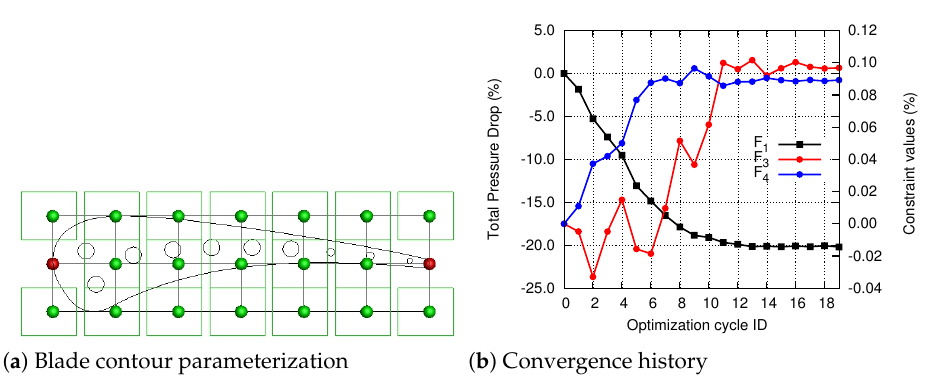
Figure 6. First optimization run.